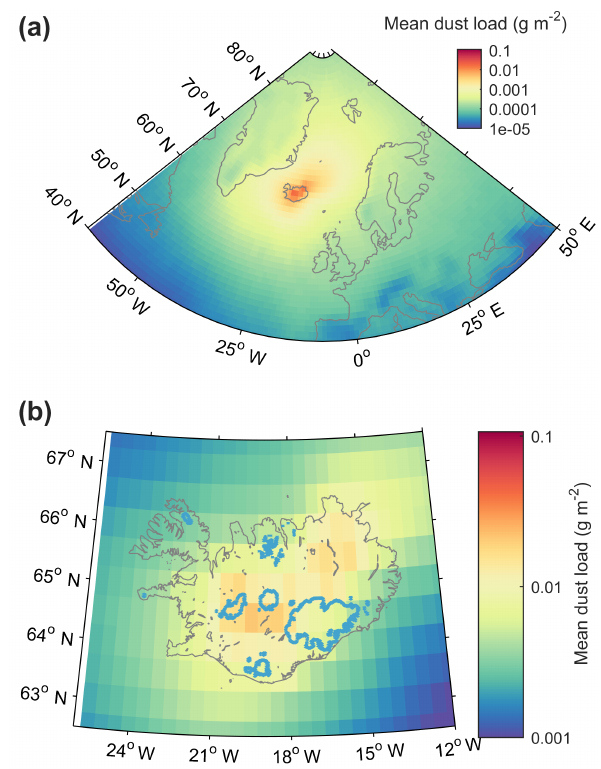
Figure 9. Mean atmospheric dust load (gm − 2 ) simulated with FLEXPART in years 1990–2016 for the North Atlantic region (a) and Iceland (b) . The blue lines in the bottom figure are glacier out-